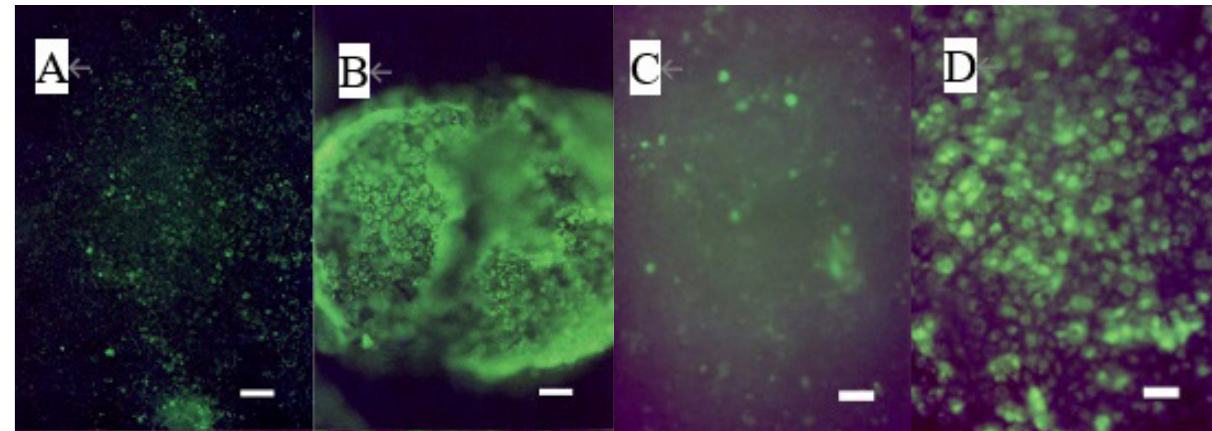
Figure 3. Induction of MMP activation of the trophoblast colony without (n = 3) (A, B) or with (n = 3) (C, D) feeder cells (fibroblasts derived from the placen - tome) by 12-KETE. Trophoblast colonies were preincubated with dye-quenched collagen for 2 h before 12-KETE addition. (A) No addition of 12-KETE, (B) At 2.5 h after 40 μM of 12-KETE addition, (white bars in A, B: 100 μm), (C) No addition of 12-KETE, (D) At 24 h after 40 μM of 12-KETE addition, (white bars in C, D: 50 μm). Replications (n = 5) of experiments showed the same results. MMP, matrix metalloproteinases; 12-KETE, 12-oxo-5Z,8Z,10E,14Z-eicosa - tetraenoic